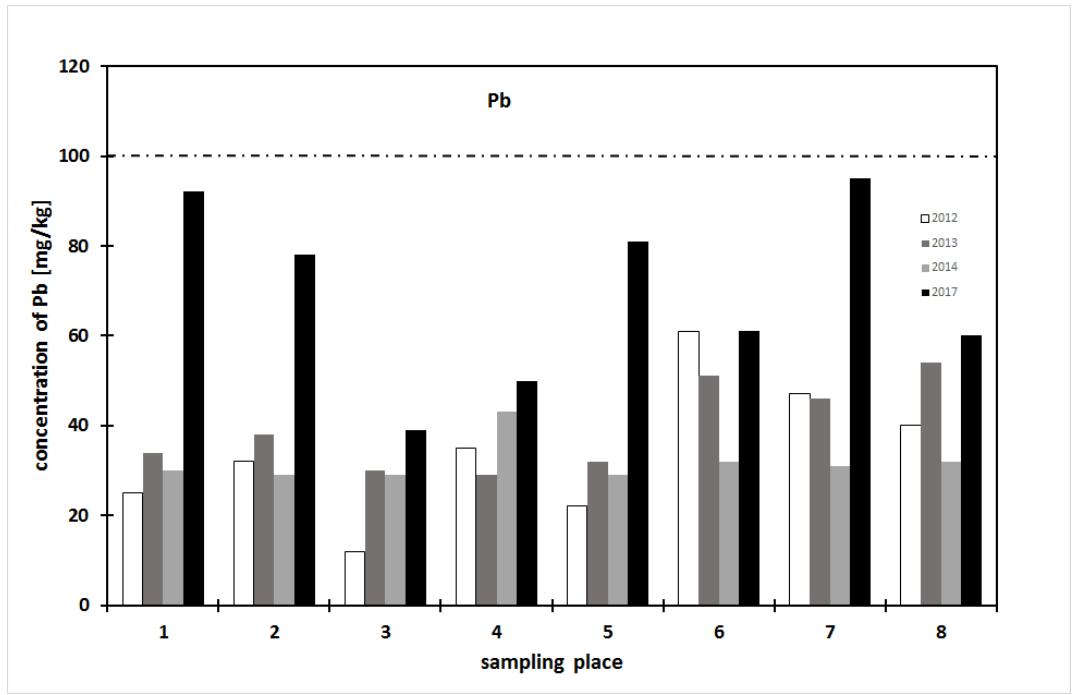
Figure 4. Content of Ni in sediments at individual sampling places in 2012, 2013, 2014, and 2017. The dashed line represents the limits for risk elements according to Annex No. 1 of the Czech Decree 257/2009 Coll. [30]. Limit of quantification <0.5 mg/kg.